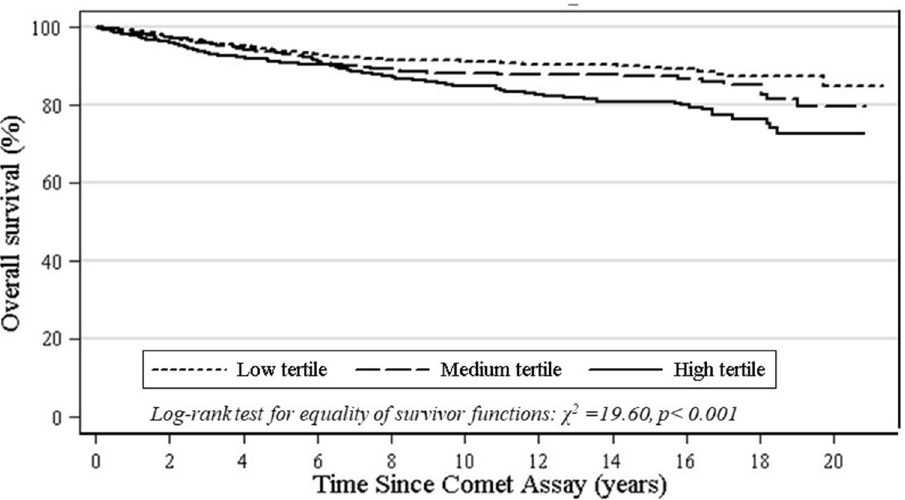
Figure 1. Kaplan–Meier curve for overall mortality by tertile of DNA damage (composite endpoint) measured with the comet assay. The hCOMET cohort.